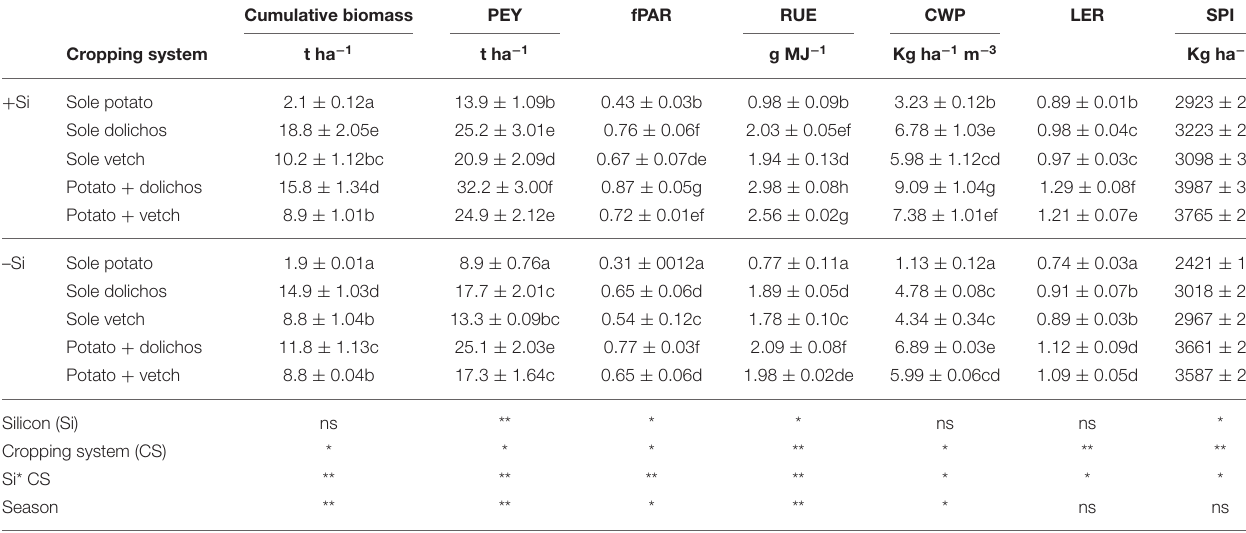
TABLE 6 | Silicon and legume intercropping effect on biomass yield, potato yield, and resource use efficiency. Cumulative